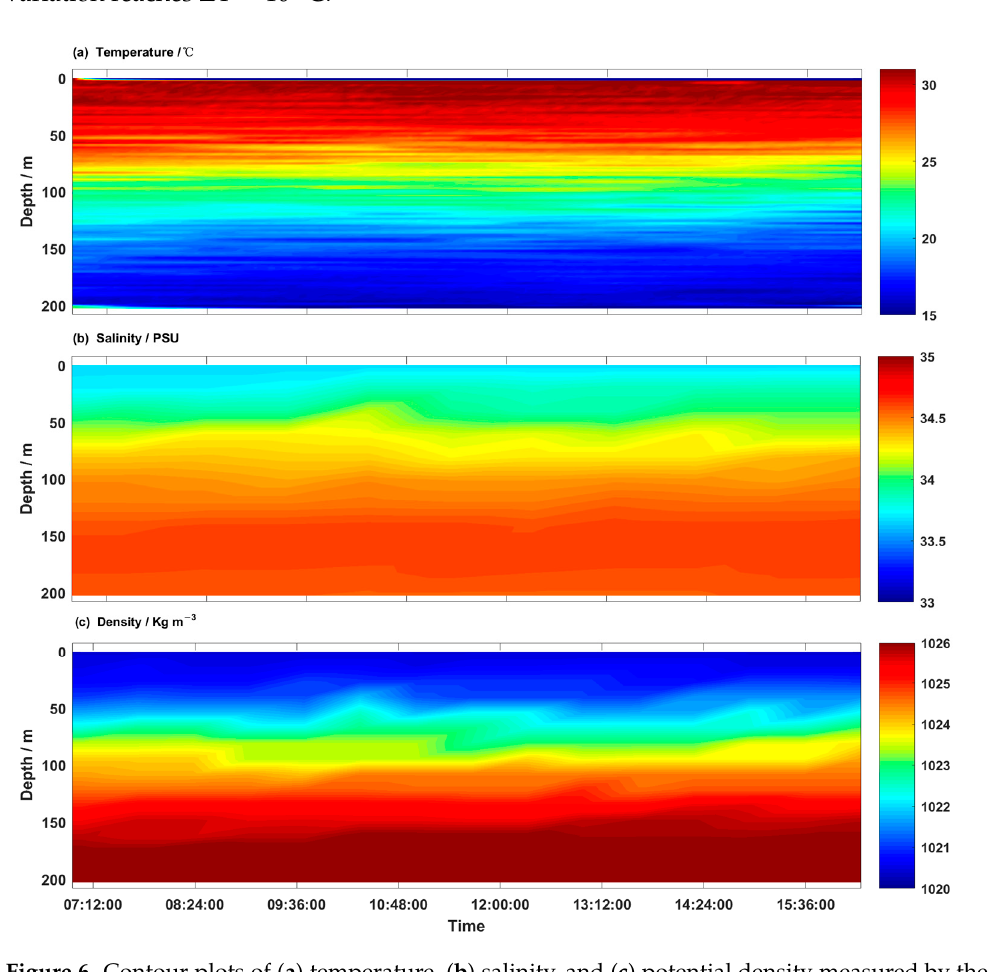
Figure 6. Contour plots of ( a ) temperature, ( b ) salinity, and ( c ) potential density measured by the hybrid AUV. According to the data, there was a thermocline between 40 and 150 m thick that separated the surface mixed layer and bottom mixed layer throughout the deployment.